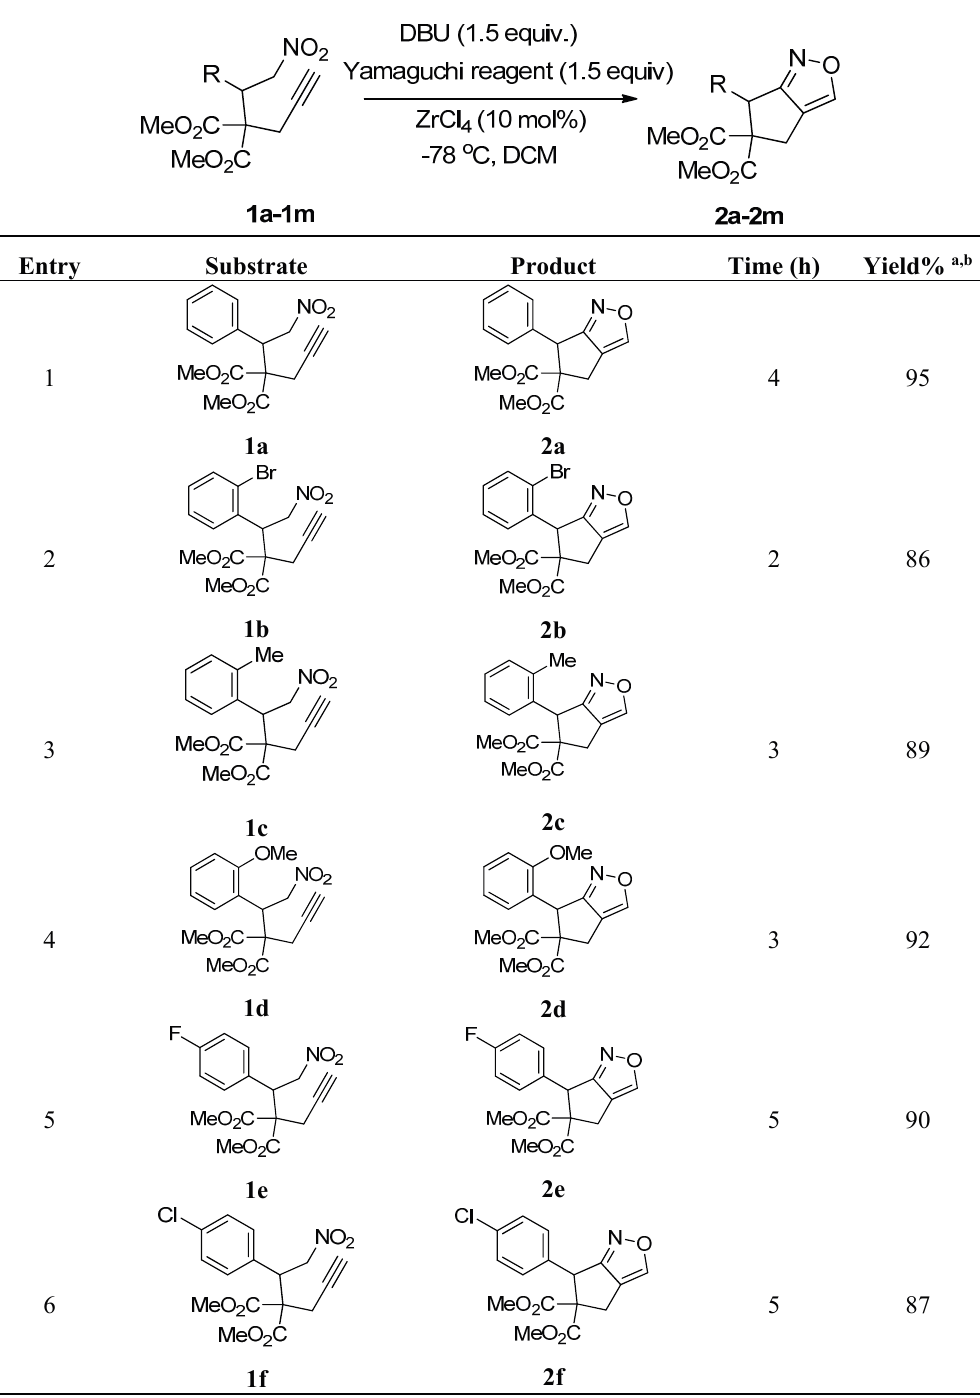
Table 2. Synthesis of bicyclic isoxazole